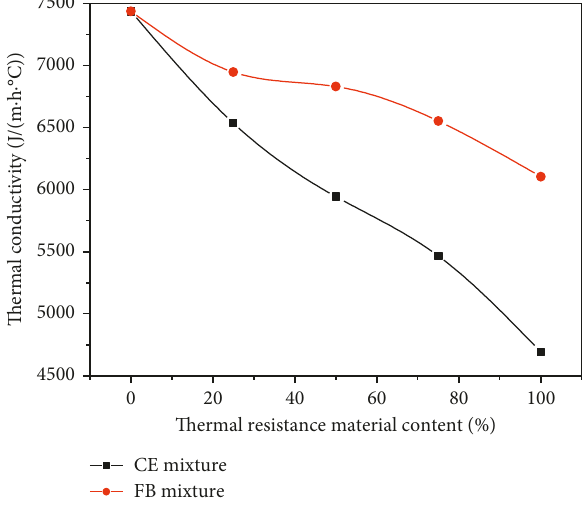
Figure 5: Results of the thermal conductivity test.